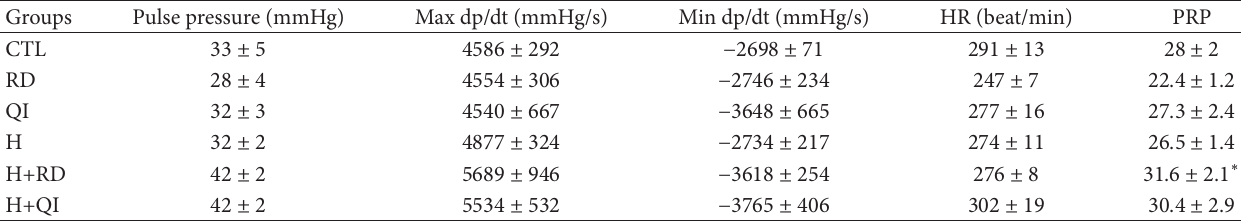
Table 2: Pulse pressure and cardiac indices in different animal groups. Groups